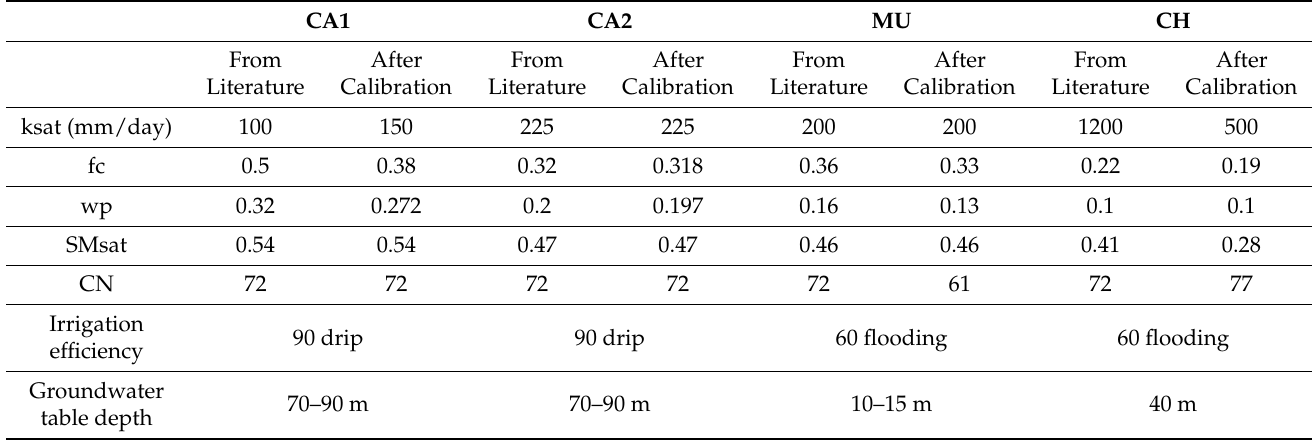
Table 2. Main calibration soil parameters for all the fields from the literature values and after the calibration process. CA1